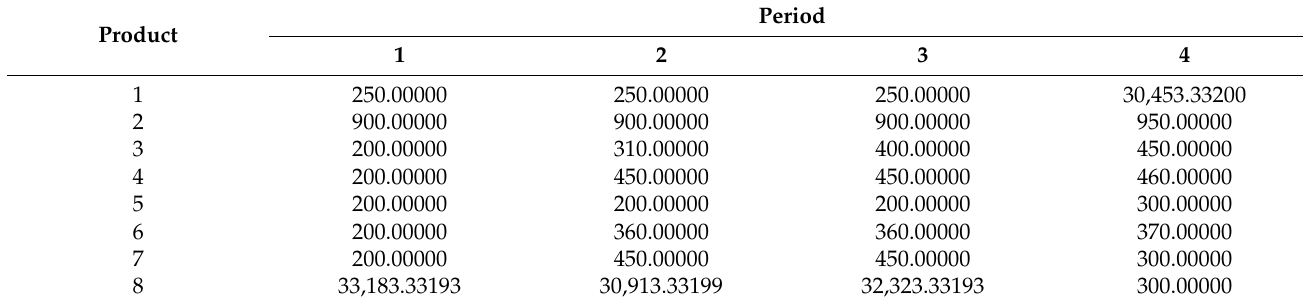
Table 11. Amount of each product in each period ( X jt ) (in